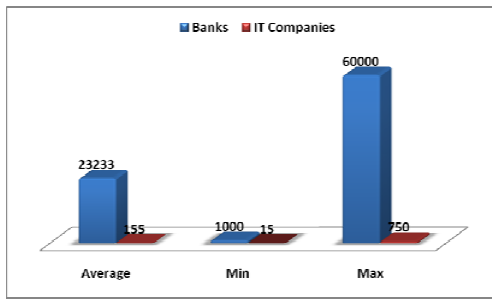
Figure 4: Number of Work